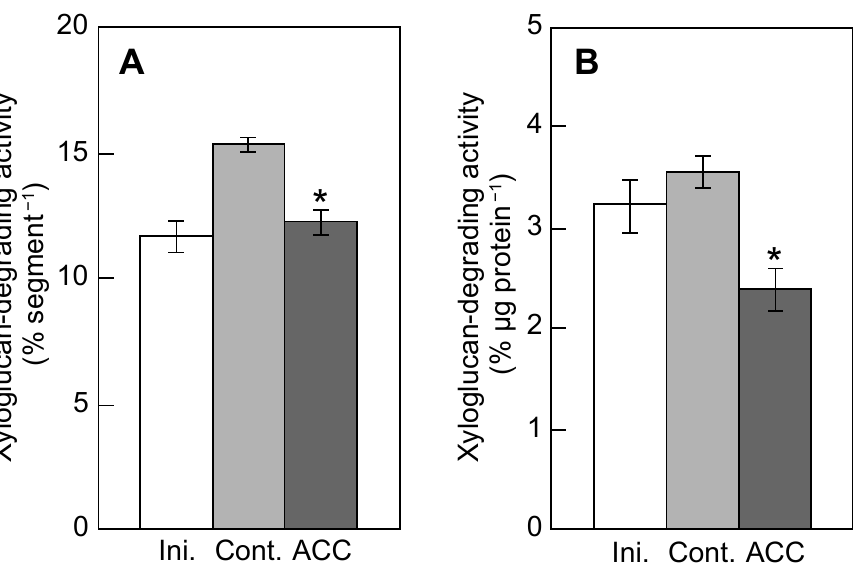
Figure 4. Activities of xyloglucan-degrading enzymes of ACC-treated azuki bean epicotyls. ACC treatment was carried out in accordance with the parameters shown in Figure 1. The activity of xyloglucan-degrading enzymes was measured by iodine staining, and indicated by the decrease in absorbance at 640 nm of the xyloglucan–iodine complex per segment ( A ) and per microgram of protein ( B ). Values are presented the means ± SE ( n = 3). * p < 0.05, mean with significant differences between control and ACC treatments.